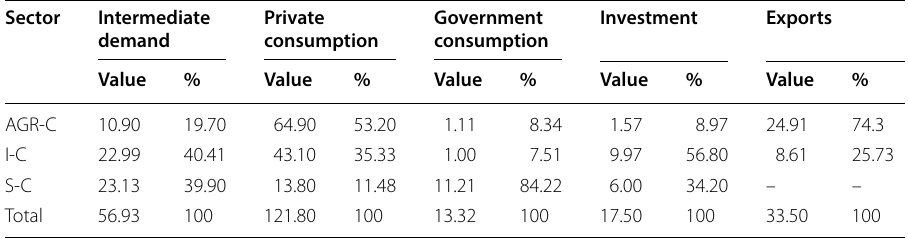
Table 9 Input–output accounting for the Oromia economy in Birr billion. Source: author’s computation using GAMS